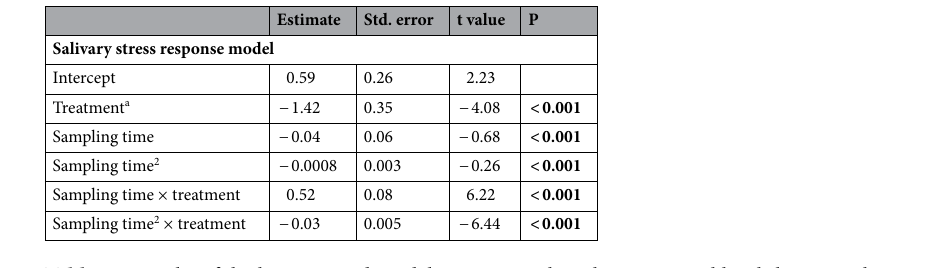
Table 3. Results of the linear mixed model comparing the salivary cortisol levels between the control and test day. a Reference category for treatment was set to control. Boldface indicates significance with P < 0.05.